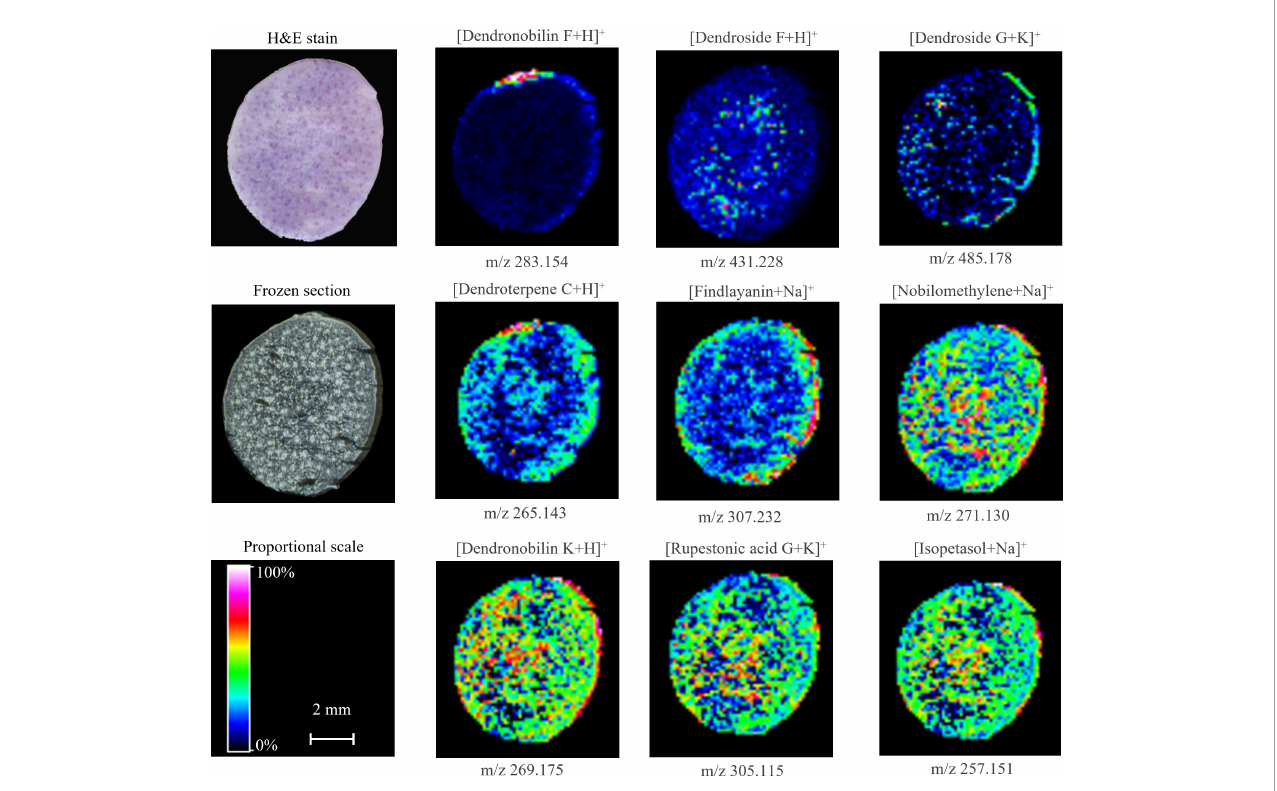
FIGURE 6 Distribution of sesquiterpenes in mature Dendrobium nobile stem imaged by MALDI-MSI. Heat maps were applied to present the relative distributions and